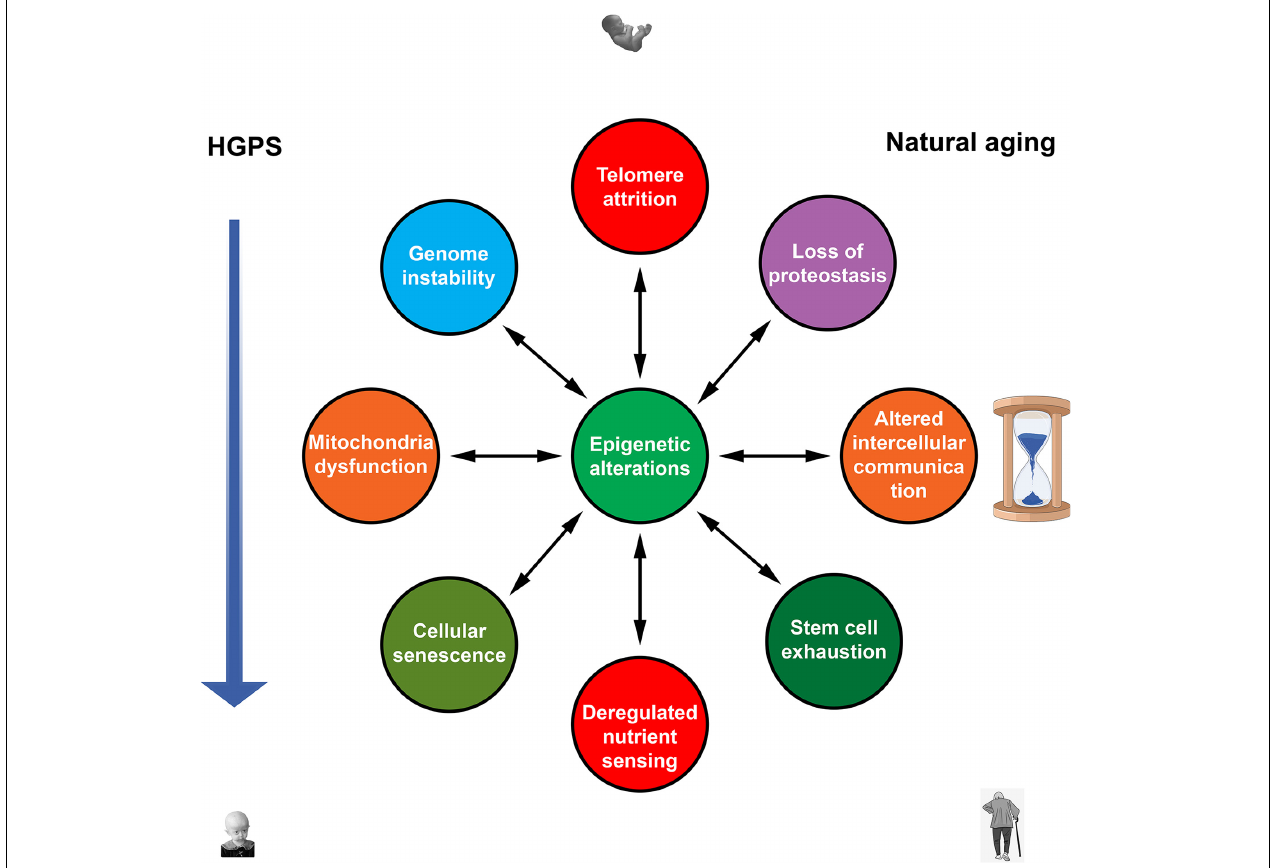
FIGURE 1 | Nine hallmarks of aging (Lopez-Otın et al., 2013) contribute to both natural and premature aging. Epigenetic alterations are in a key position to affect all hallmarks of aging and to be affected by them. Mutual influences between other hallmarks that probably exist are not shown.